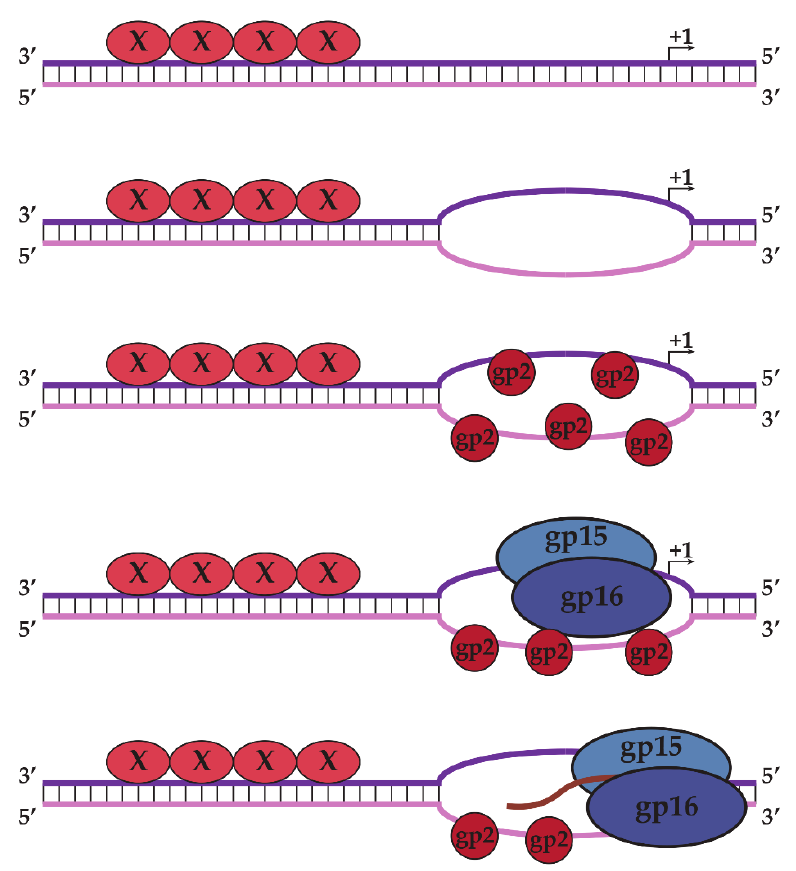
Figure 7. Model of middle transcription by N4 RNAPII. AT-rich double-stranded promoters are specifically recognized and melted by an unknown protein “X,” allowing gp2 to bind to single-stranded DNA. Gp2 recruits N4 RNAPII to the promoter through direct interactions, allowing N4 RNAPII to recognize specific sequences in the template strand and initiate transcription. Template and non-template strands of promoter DNA are represented as purple and pink,